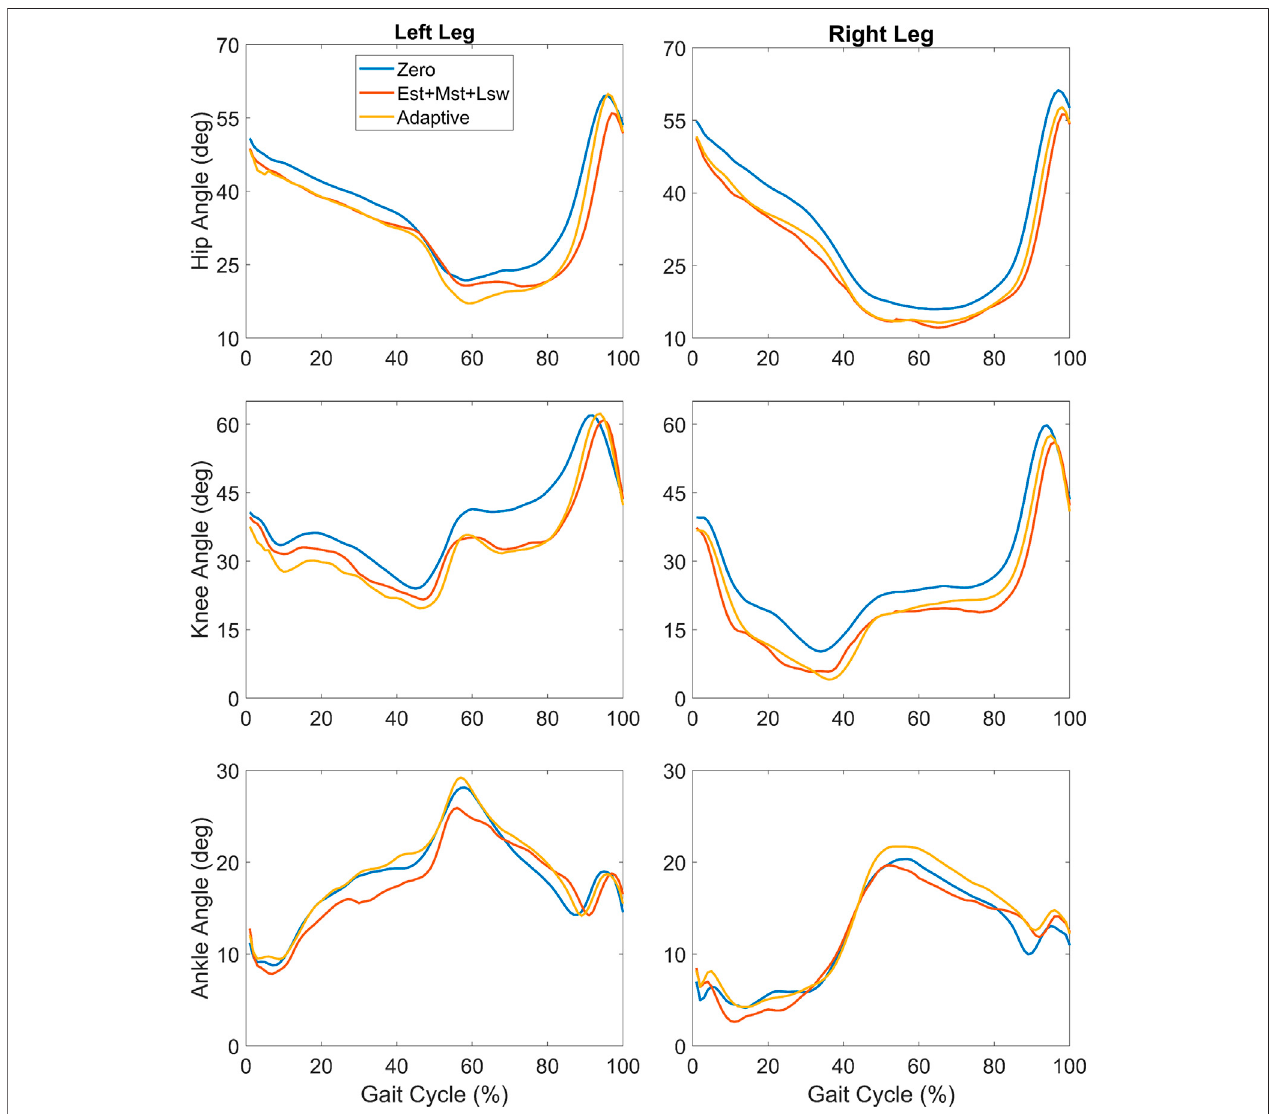
FIGURE6| Meanlowerextremityjointangles acrossthegait cycleduring overground walkingwithexoskeleton assistance provided bytheConstant modeduring early stance, mid-stance and late swing (Est+Mst+Lsw; orange), Adaptive mode (yellow) and a baseline condition with no extension assistance (Zero; blue).